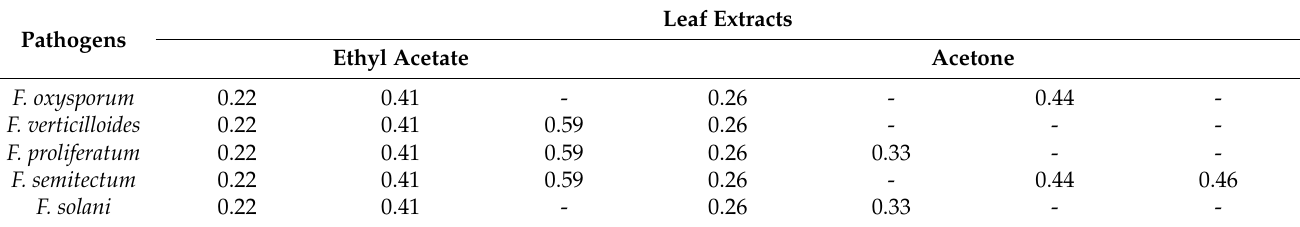
Table 2. R f values of antifungal bands in Withania somnifera leaf extracts using the TLC bioautography assay. Pathogens